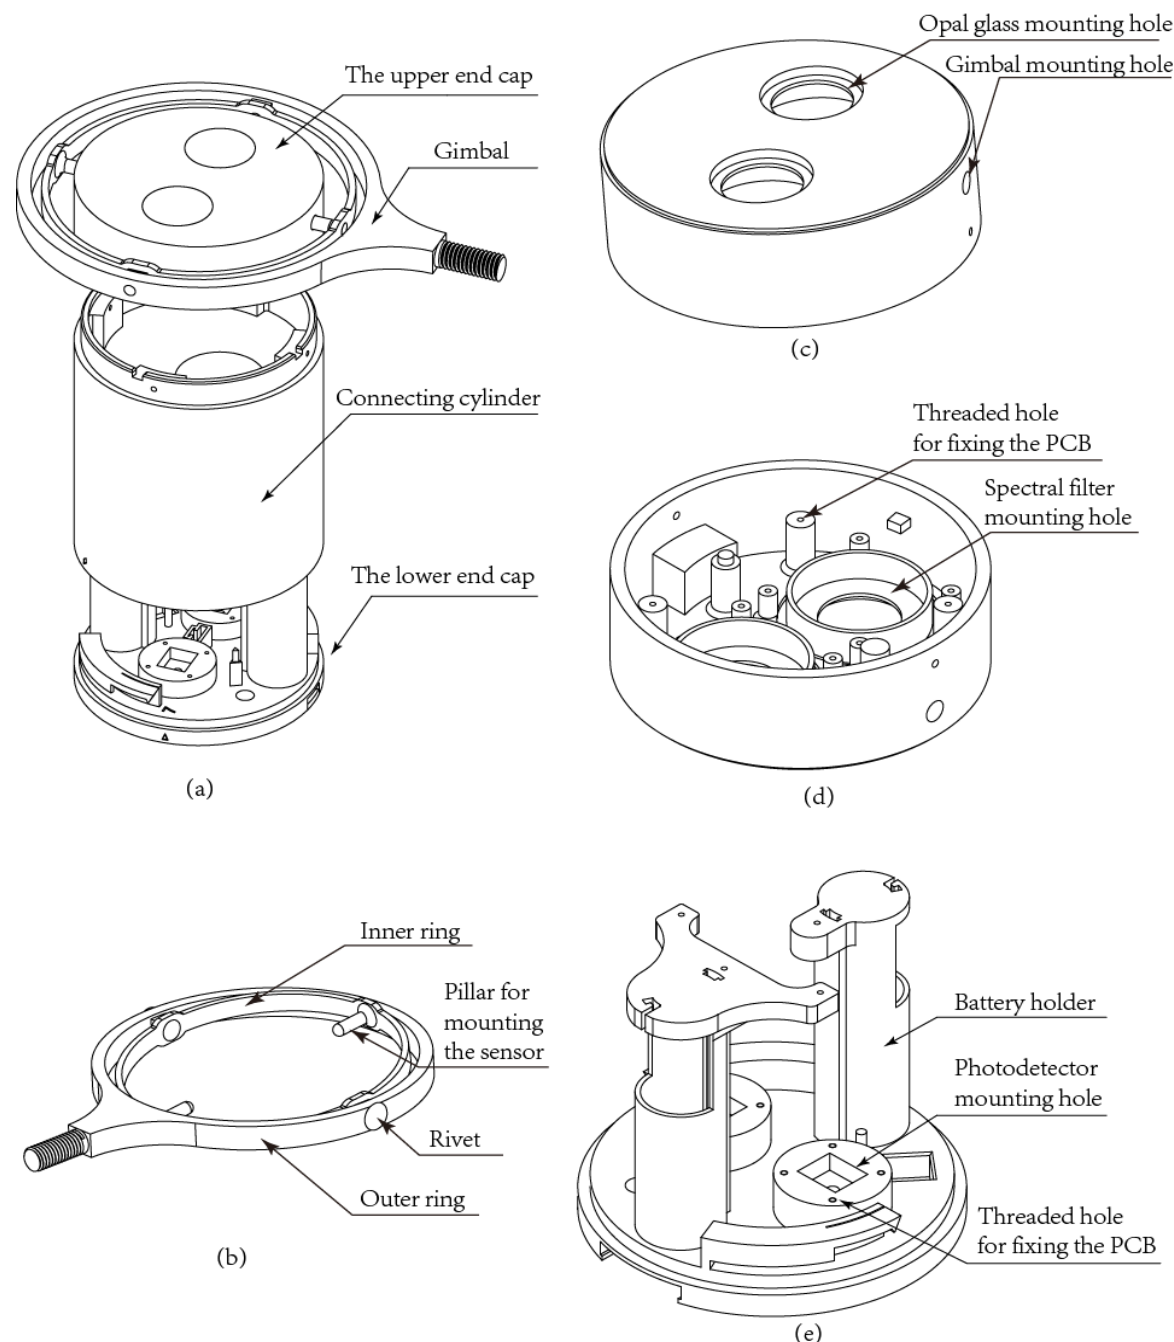
Figure 2. Structural diagram of the sensor. ( a ) Exploded diagram; ( b ) Gimbal; ( c ) The upper end cap (top view); ( d ) The upper end cap (bottom view); ( e ) The lower end cap. For crop growth information sensors that use direct sunlight as the light source, the upper surface receiving sunlight and the lower surface receiving reflected light from crops are required to be in a horizontal position during operation; otherwise, the measurement study, a gimbal (Figure 2a) that can be mounted on the sensor was designed. The gimbal consists of two rings. The inner ring has a pilar for mounting the sensor. Under the gravity of the sensor, the sensor is able to swing freely to achieve the purpose of automatic bal- ancing.